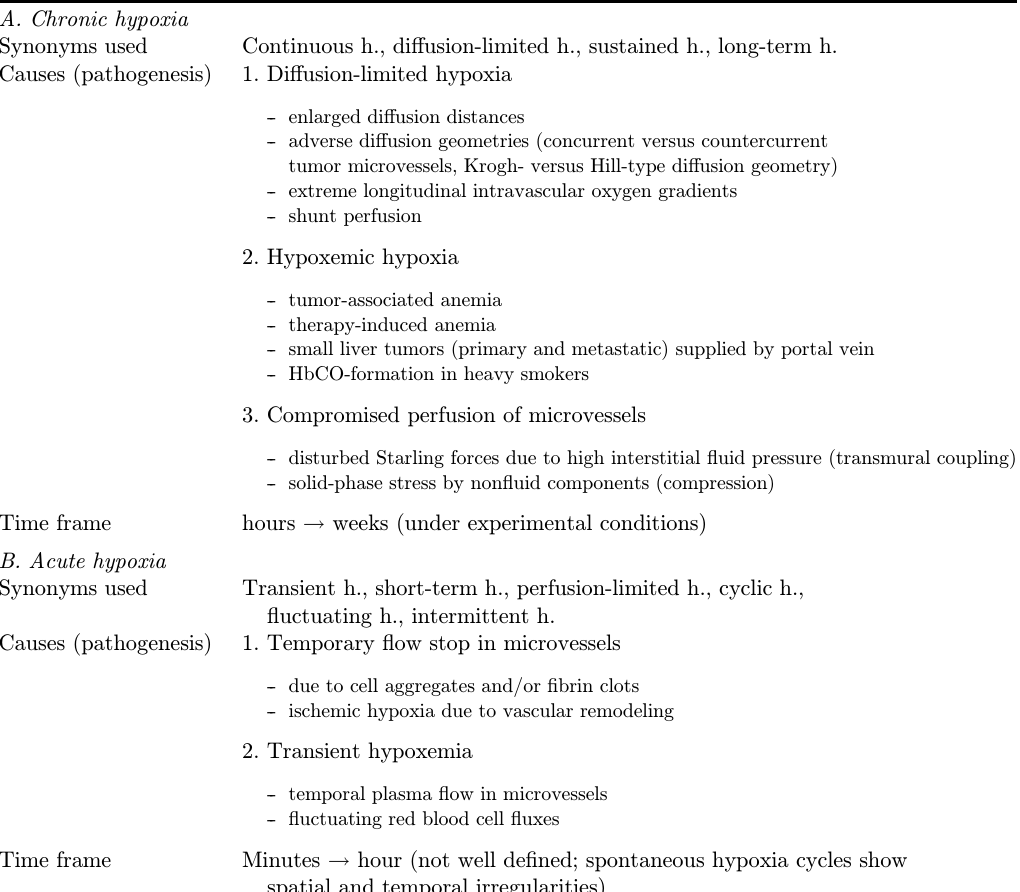
Table 1. Causes and time frames of chronic and acute hypoxia (selection of mechanisms, modi¯ed 17